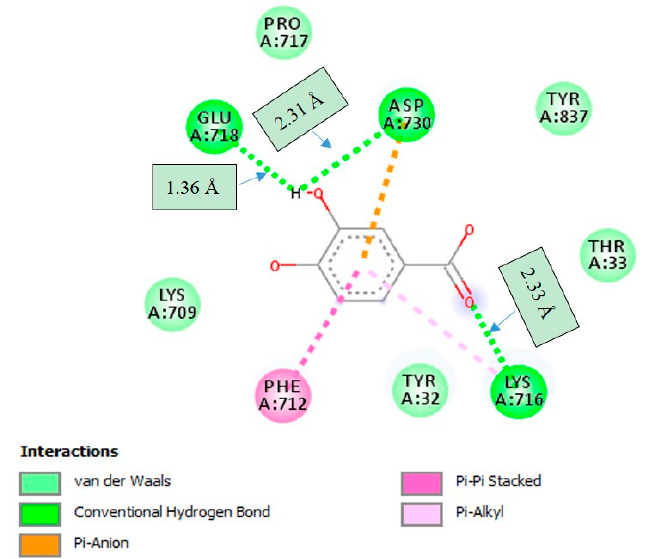
Figure 6. 2D interaction diagram of protocatechuic acid (PCA) in the active site of jack bean urease (JBU; PDB code: 3LA4). Only those amino acid residues involved in JBU stabilization are shown. Hydrogen bonding interactions with amino acid residues at corresponding distances are shown.